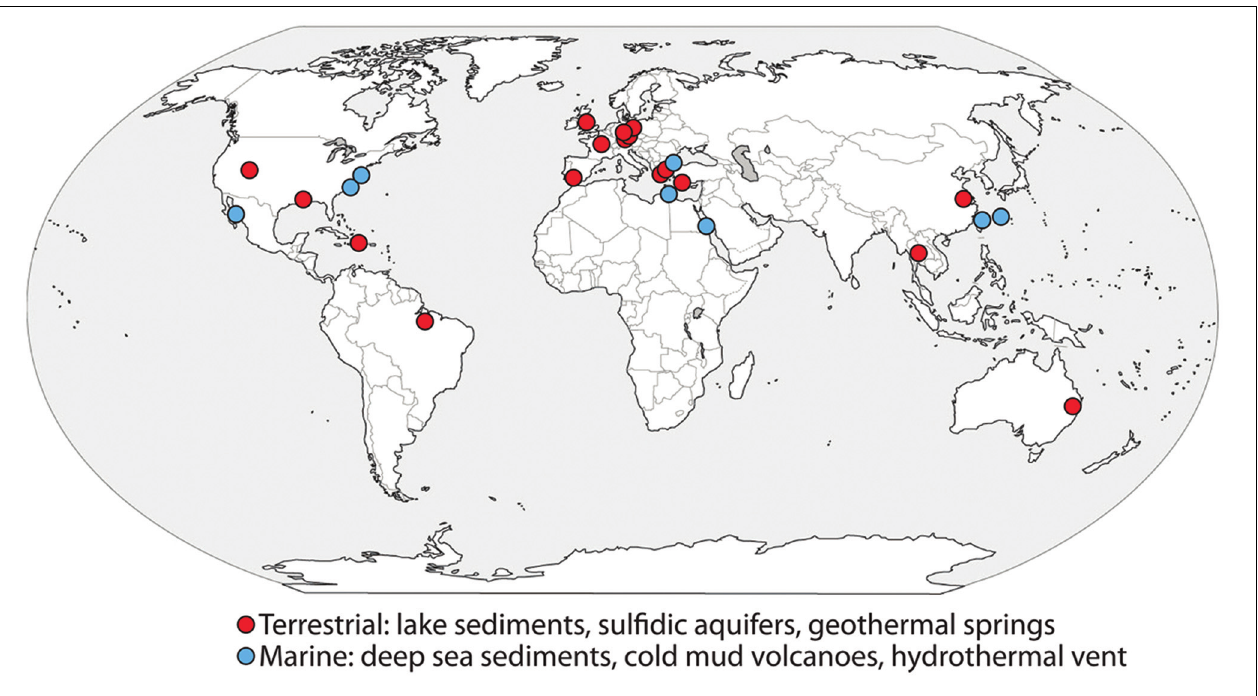
FIGURE 1 | Global distribution of Altiarchaeales 16S rRNA gene sequences present in the NCBI